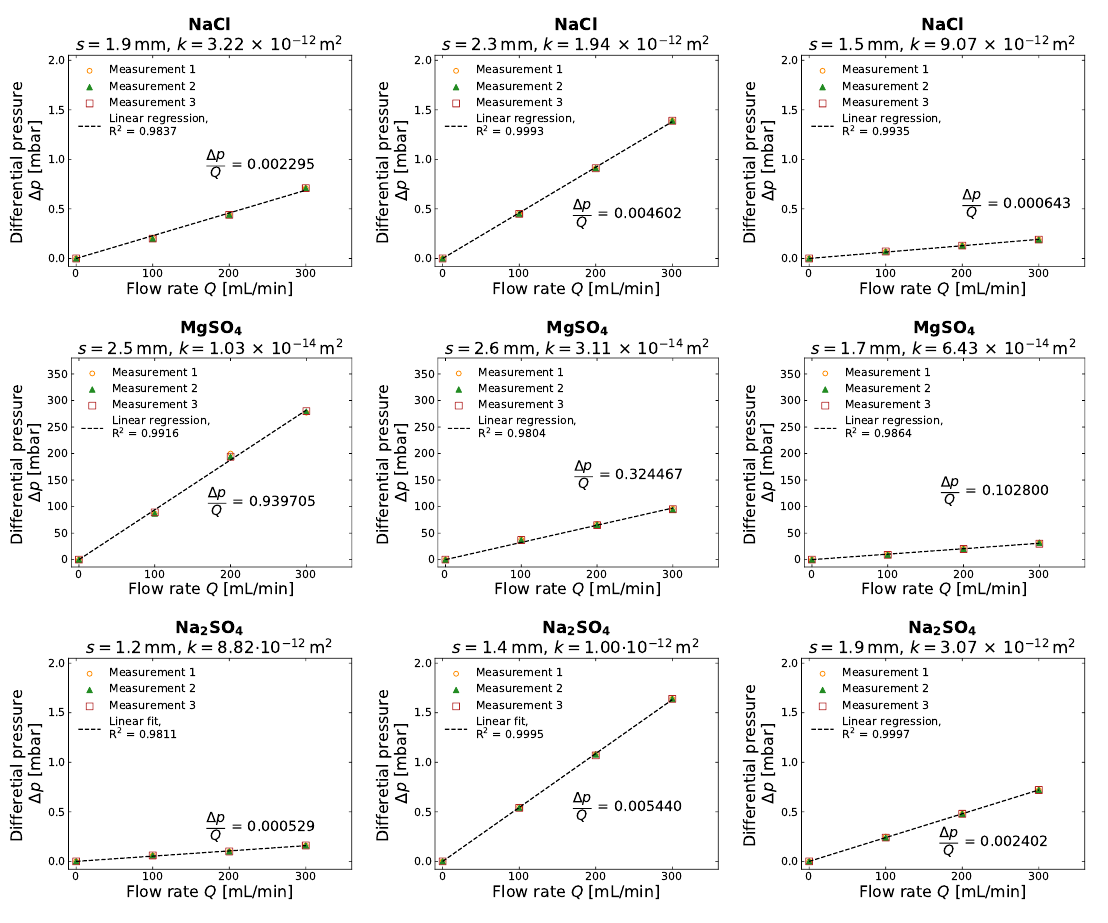
Figure A2. Pressure difference as a function of gas flow rate for all crusts in the wet state (i.e., directly after evaporation). The crust thickness s and the permeability k obtained with Equation (2) are provided in the title of each